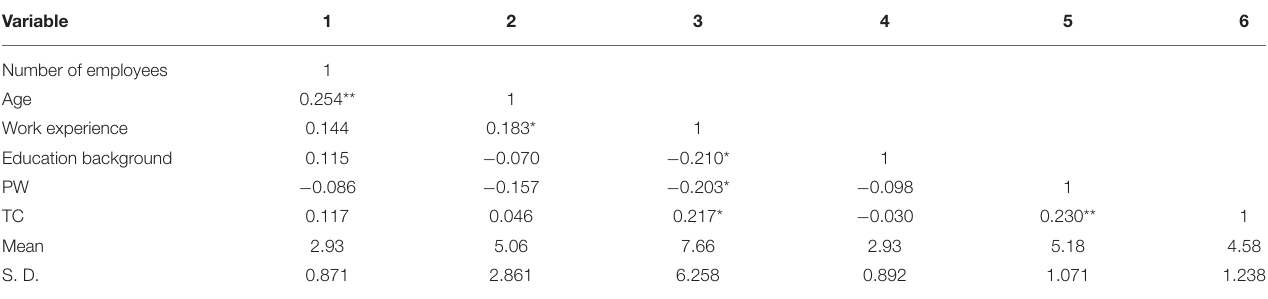
TABLE 2 | Descriptive statistics and correlation analysis.